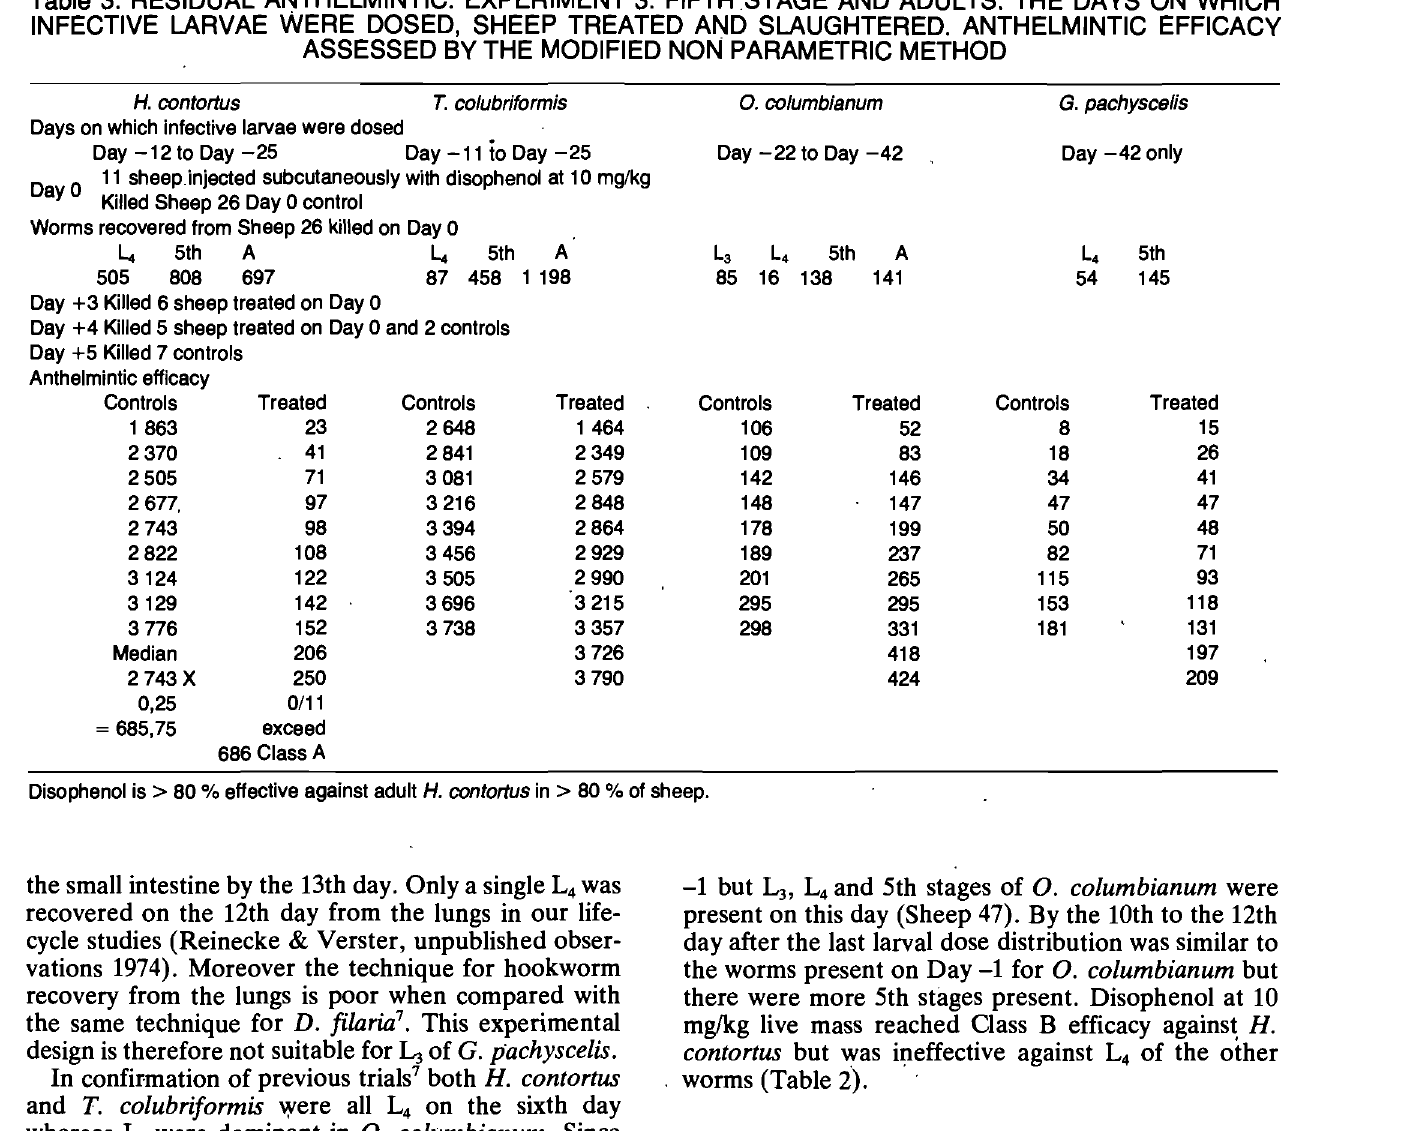
Table 3: RESIDUAL ANTHELMINTIC. EXPERIMENT 3. FIFTH STAGE AND ADULTS. THE DAYS ON WHICH INFECTIVE LARVAE WERE DOSED, SHEEP TREATED AND SLAUGHTERED. ANTHELMINTIC EFFICACY ASSESSED BY THE MODIFIED NON PARAMETRIC